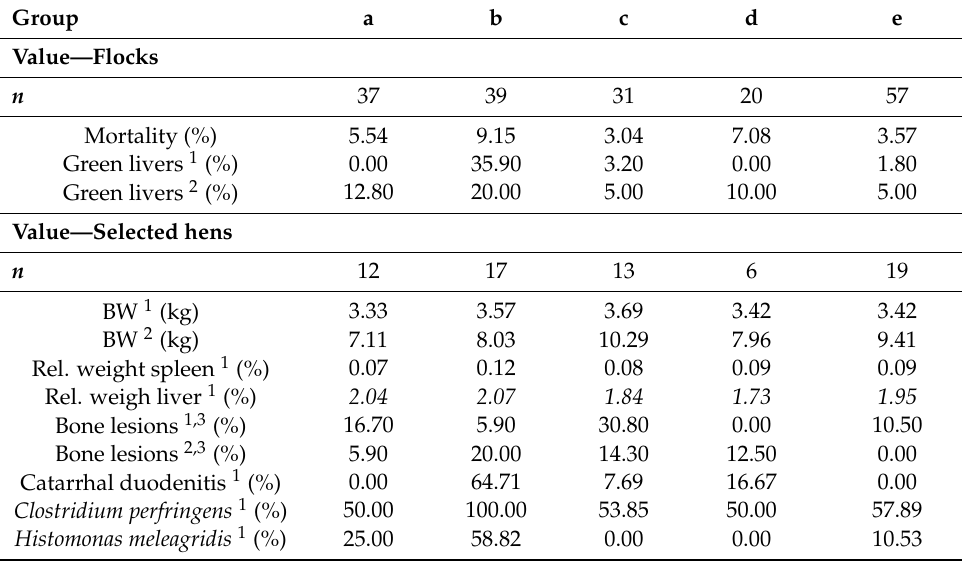
Table 3. Presentation of different values for flocks or selected hens of (a) hens unvaccinated against HEV with detection of TAdV-5, (b) hens unvaccinated against HEV with detection of HEV, (c) HEV- vaccinated hens with the detection of HEV, (d) HEV-vaccinated hens without AdV-detection, and (e) hens unvaccinated against HEV without AdV-detection. The presented data includes means ( x ), except for the relative liver weight, which is given as medians ( (cid:101) x